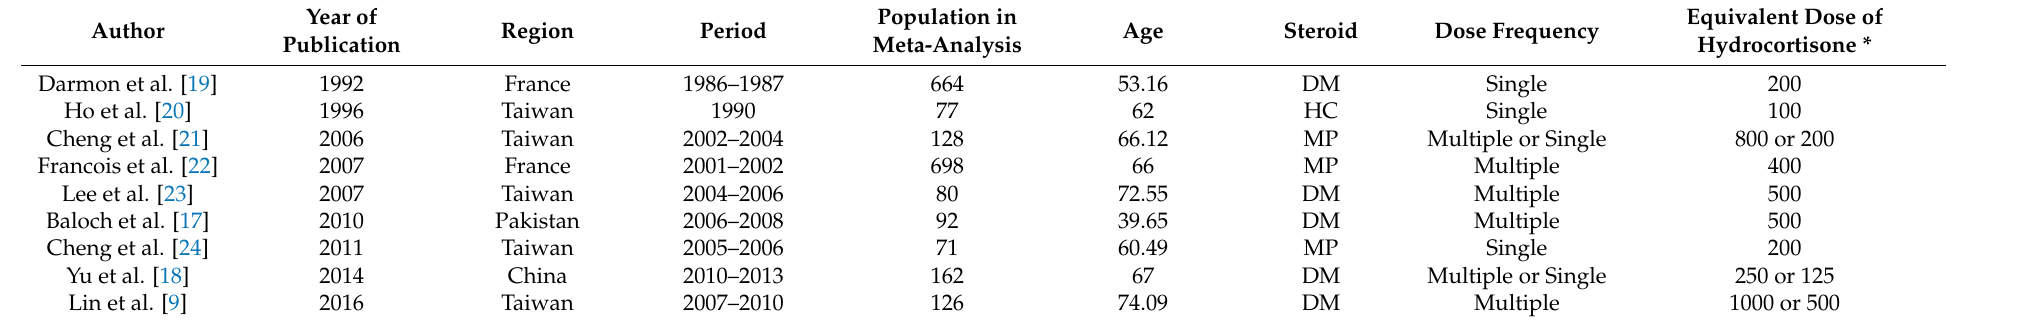
Table 1. Baseline characteristics of included